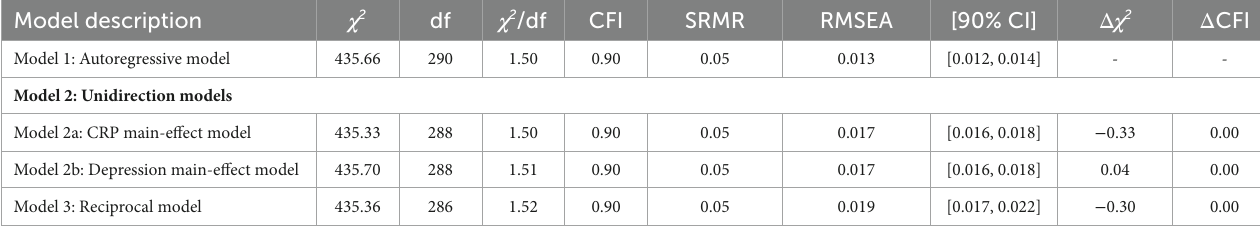
TABLE 4 Fit indices of the various cross-lagged models. Model description